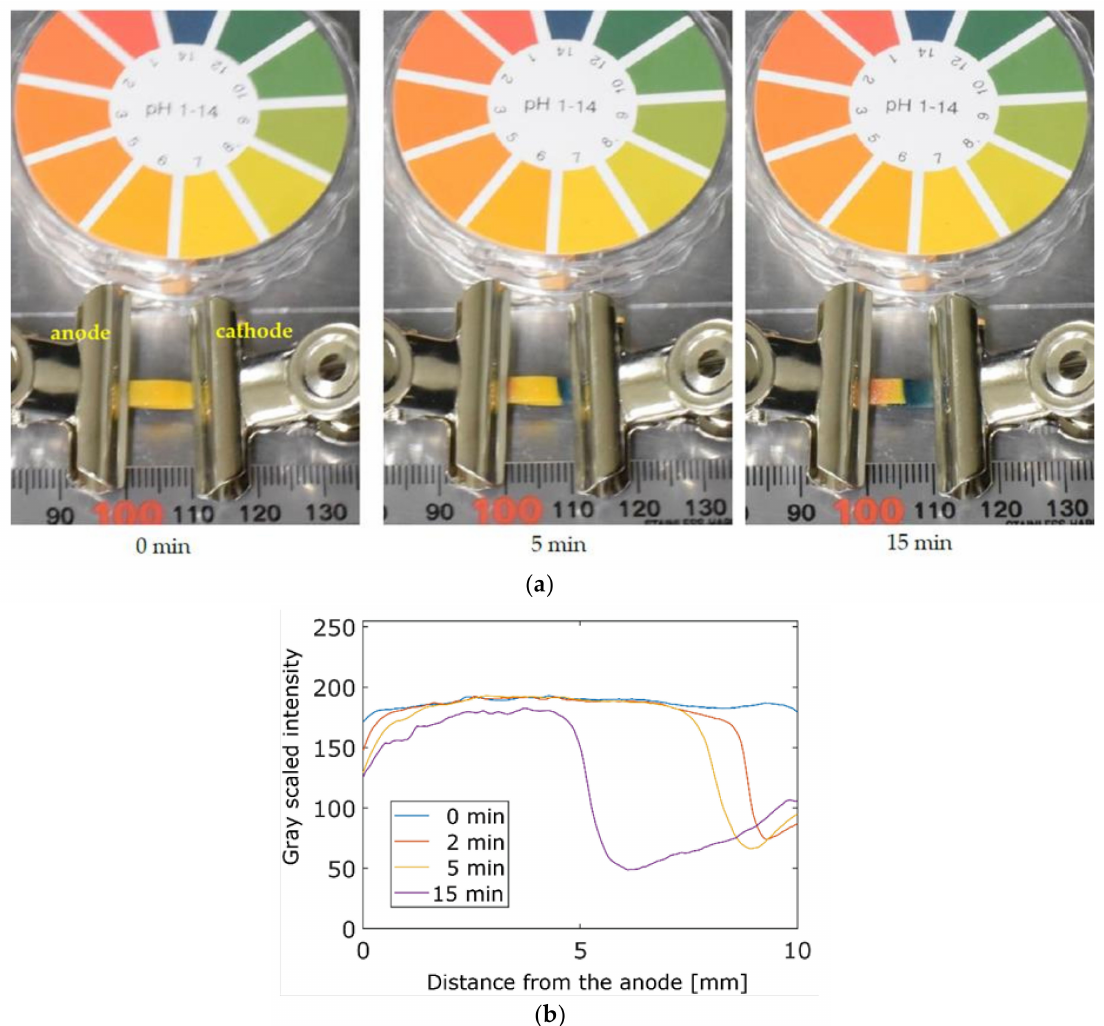
Figure 2. Time evolution of pH distribution after applying voltage to the bu ff er solution. ( a ) Typical photo images of the pH test paper. ( b ) Gray-scaled intensity distribution between the